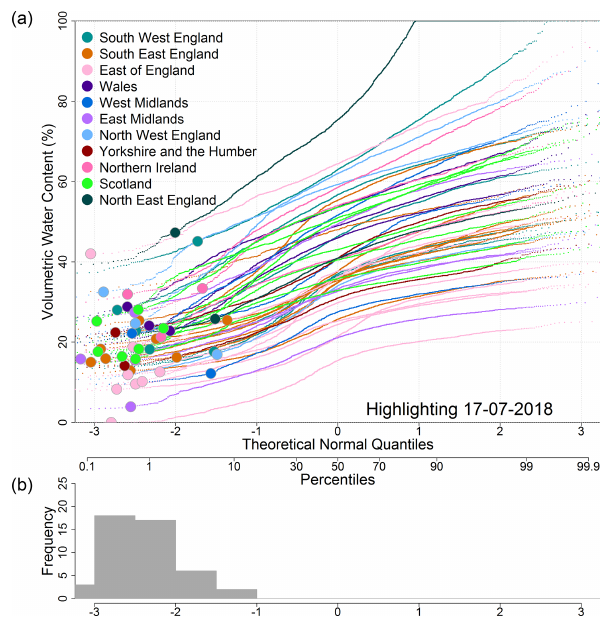
Figure 6. Soil moisture regime plot for all COSMOS-UK sites grouped by region (dot colour) according to the Nomenclature of Territorial Units for Statistics (NUTS) codes of the United King- dom. The (a) dots and (b) histogram represent the soil moisture and corresponding frequency respectively, on 17 July 2018 when there was a widespread drought across the UK. Each line represents the distribution of CRNS VWC at a COSMOS-UK site; sites with wet- ter regimes plot higher up in the